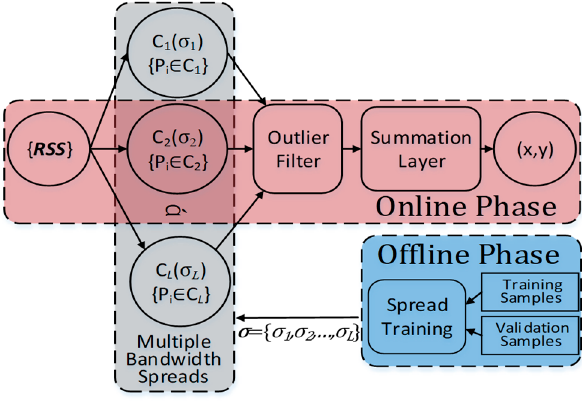
Figure 3. Outlier filter indoor positioning approach (GROF) block diagram.